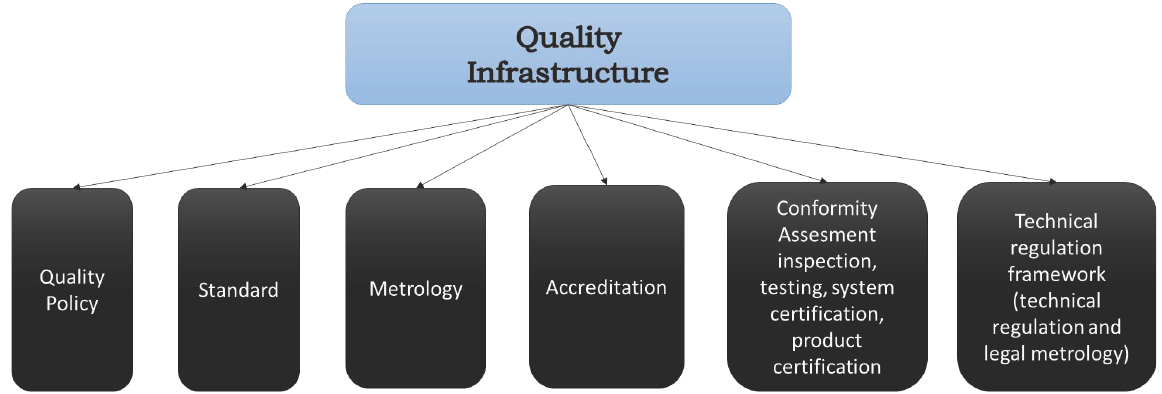
Figure 1: Building of quality infrastructure [14]